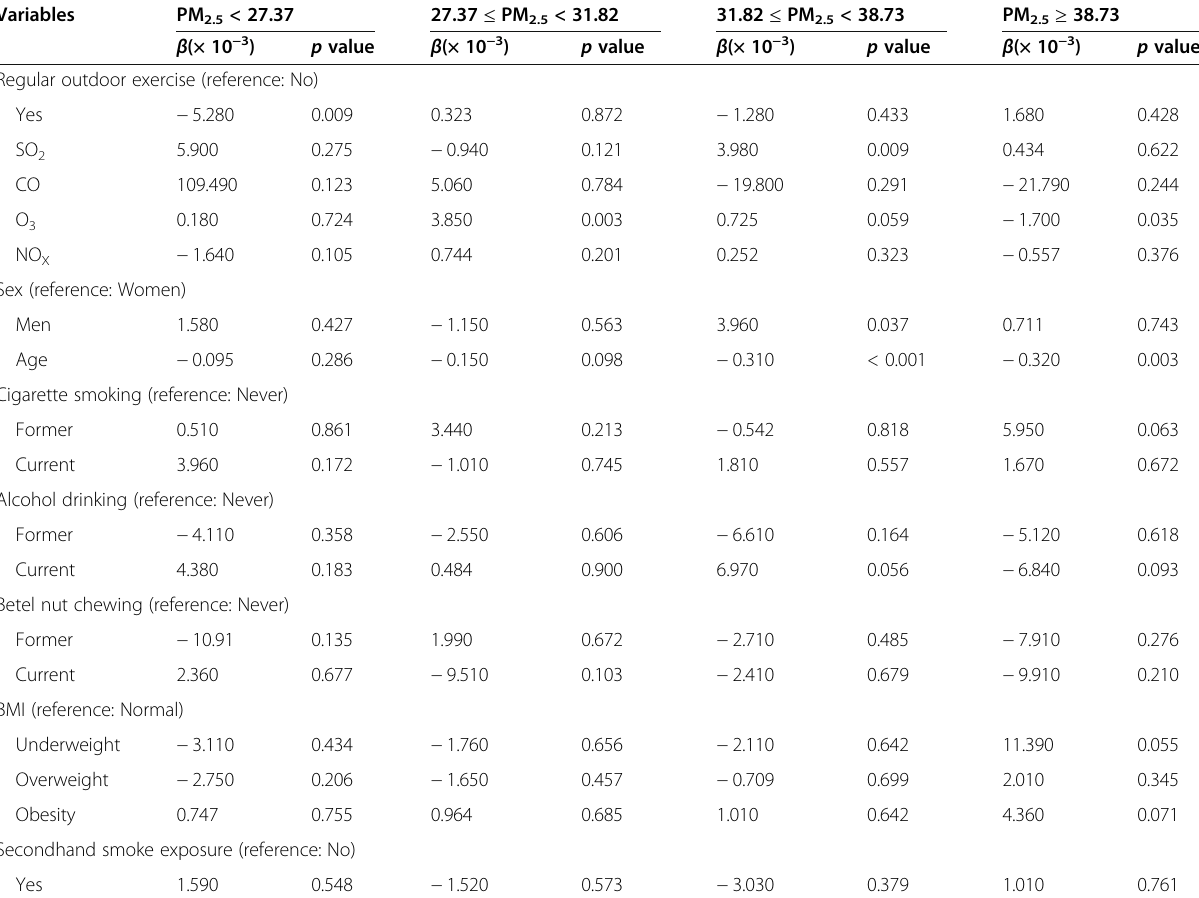
Table 4 Multiple linear regression showing the association between outdoor exercise and DLEC1 promoter methylation stratified by PM 2.5